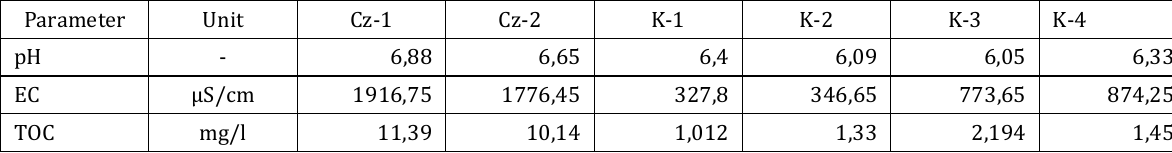
Table 2. Basic statistics for the selected parameters in groundwater